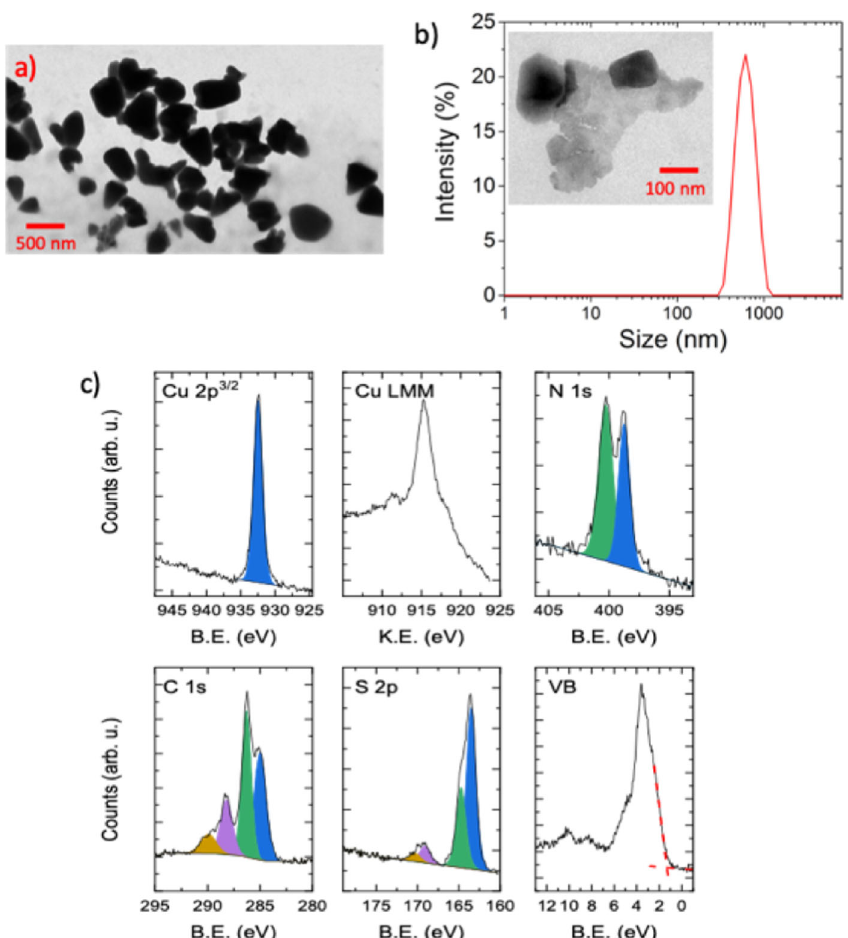
Fig. 1 Physico-chemical characterization of CuSCN-NP. a Representative TEM image of CuSCN-NP from water dispersion employing keratin as surfactant and b size distribution measured by DLS, with TEM image at high magni fi cation in the inset showing the presence ofsigni fi cantly thin platelets within the sample. c XPS characterization of CuSCN-NP: top left, Cu 2p 3/2 XPS peak with fi tted Cu(I)SCN component (blue); top center, Cu LMM Auger spectrum; top right, N 1s XPS spectrum fi tted with SCN (blue) and thiourea (green) component; bottom left, C 1s XPS region with aliphatic (blue), SCN (green), thiourea (violet), carboxylate (ochre) components; bottom center, S 2p region with the main doublet assigned to SCN and thiourea (2p 3/2 blue, 2p 1/2 green), and the satellite doublet corresponding to oxidized sulfur (violet and ochre); bottom right, XPS valence band spectrum with red dashed lines indicating the valence band